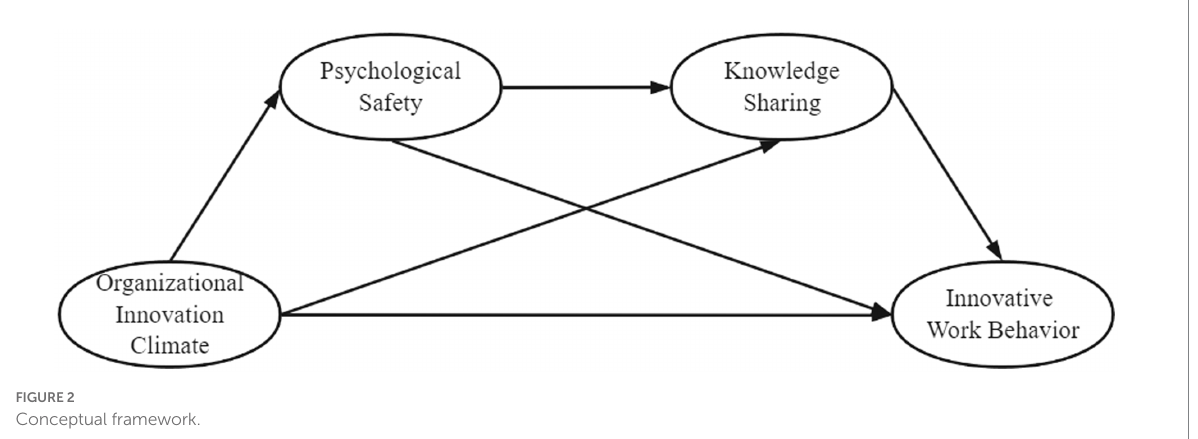
FIGURE 2 Conceptual framework.